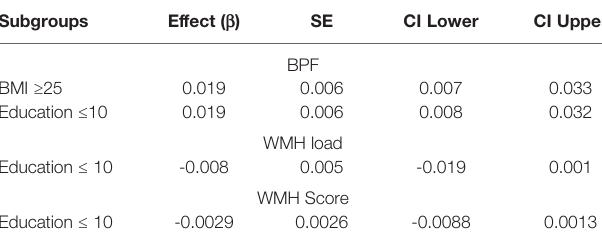
FIGURE 2 | Mediation analysis of LTL on attention/speed via BPF in subgroups of BMI ≥ 25 and Education ≤ 10y where LTL was signi fi cantly associated with both BPF and attention/speed. Mediation is calculated after adjusting for covariates from Model III of linear regression. a- effect of LTL on BPF, b-effect of BPF on attention/speed, c-total effect of LTL on attention/speed, and c ’ -direct effect of LTL on attention/speed when controlled for BPF. It shows partial mediation because total effect (c) of LTL on attention/speed is reduced in the presence of BPF (c ’ ). LTL, Leukocyte Telomere Length; BPF, Brain Parenchymal Fraction. TABLE 4 | Mediation